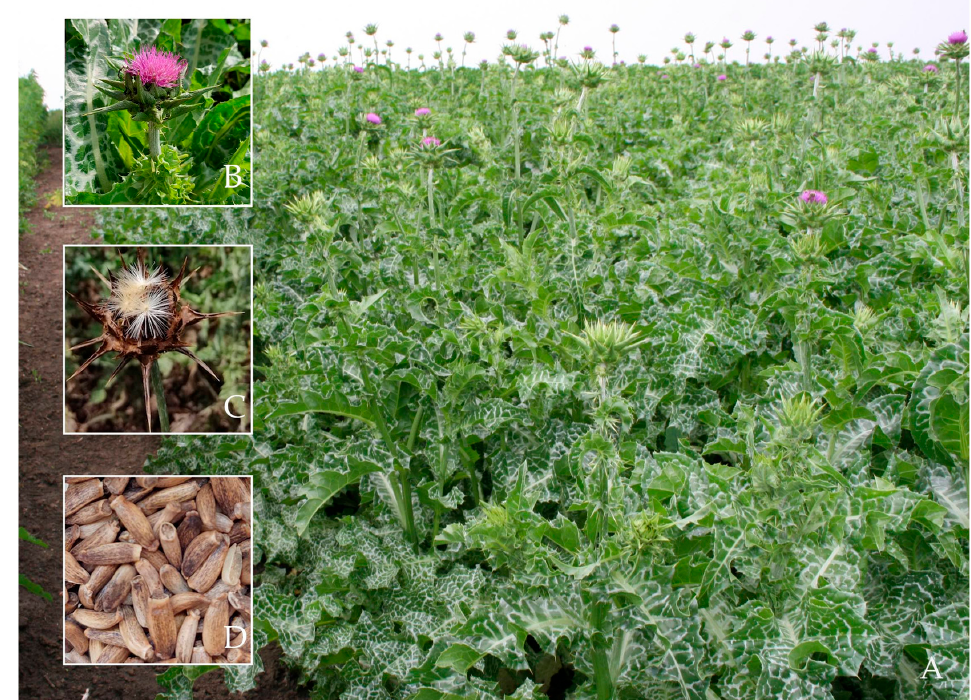
Figure 1. Milk thistle ( Silybum marianum (L.) Gaertn). ( A ) Cultivated field at the Agricultural Research and Development Station (SCDA) Secuieni, Neam ț County, Romania. ( B ) Flower head with spiny bracts and variegated leaf. ( C ) Mature flower ( D ) Fruits (Photos: A.C. Raclariu-Manolic ă ; M. Naie).